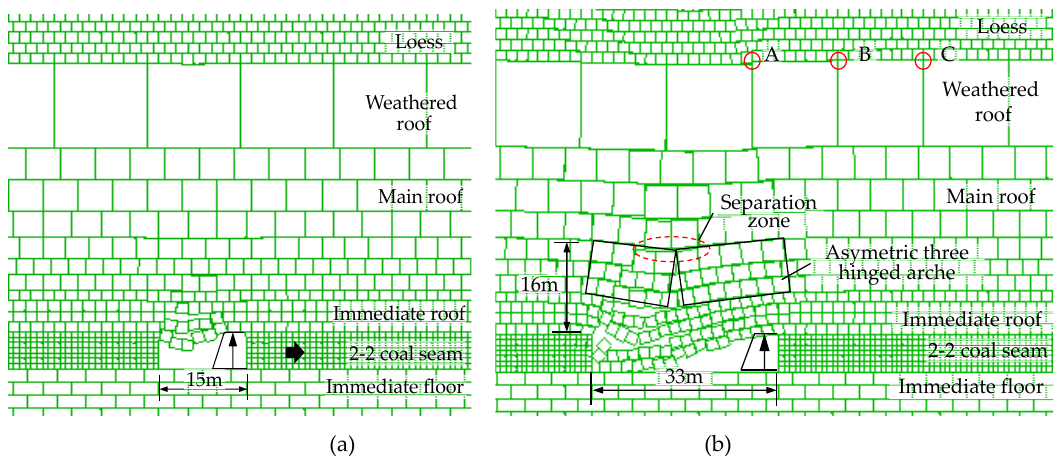
Figure 29. Overburden structure under different distances: (a) advanced to 15m; (b) advanced to 33m. The distance between the boundary pillars on both sides is 50 m in simulation model. By